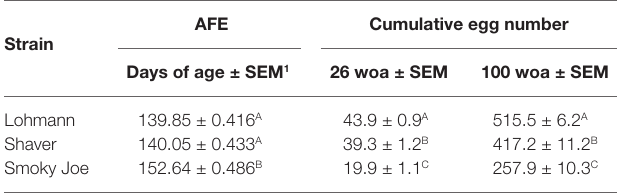
TABLE 4 | The AFE and cumulative egg number at 26 and 100 woa within each